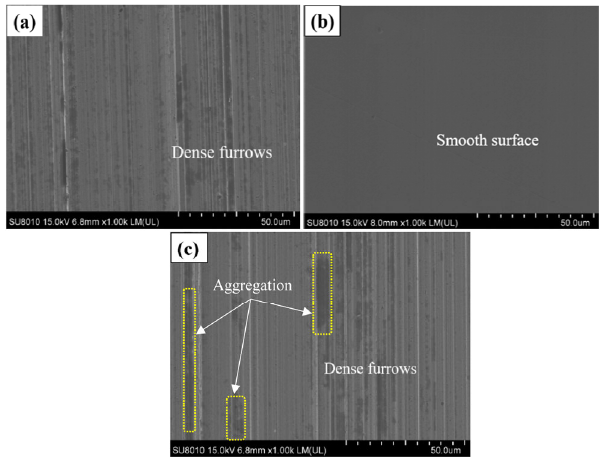
Fig. 8 SEM micrographs of the rubbed surfaces of the lower disk lubricated by PAO6 containing different mass concentrations of TiL 4 /BP nanocomposites under the load of 20 N: (a) 0.005%, (b) 0.01%, and (c) 0.05%.